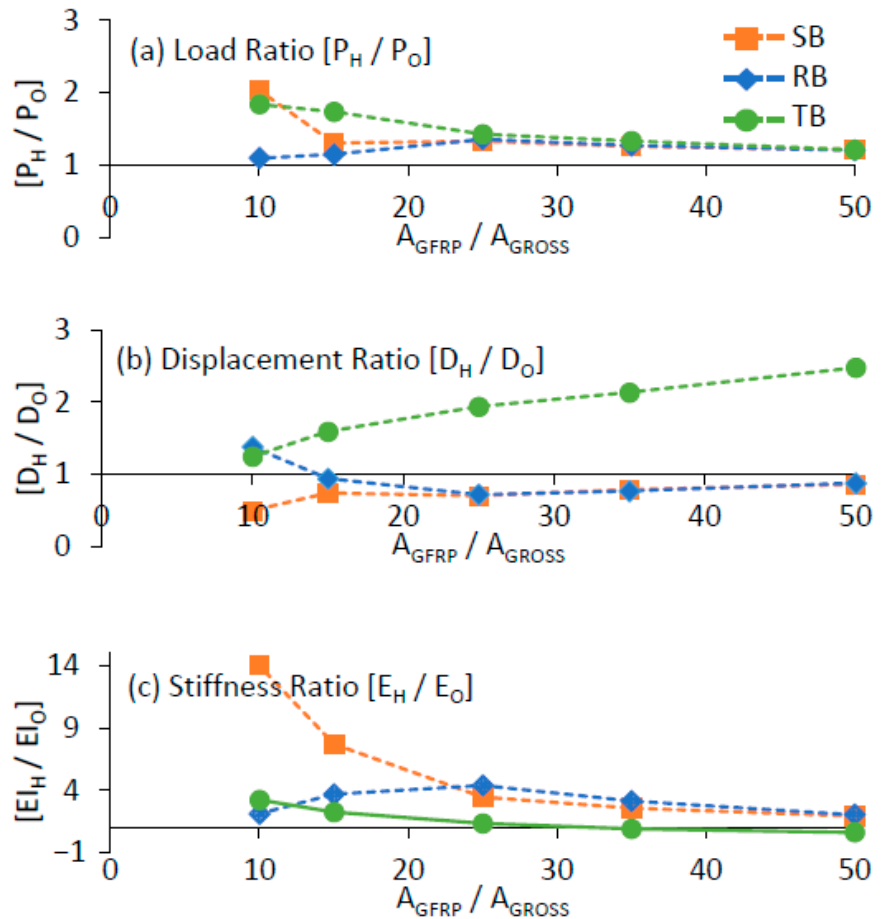
Figure 8. Effect geometrical shape on ( a ) loads; ( b ) deflections; ( c ) stiffness.